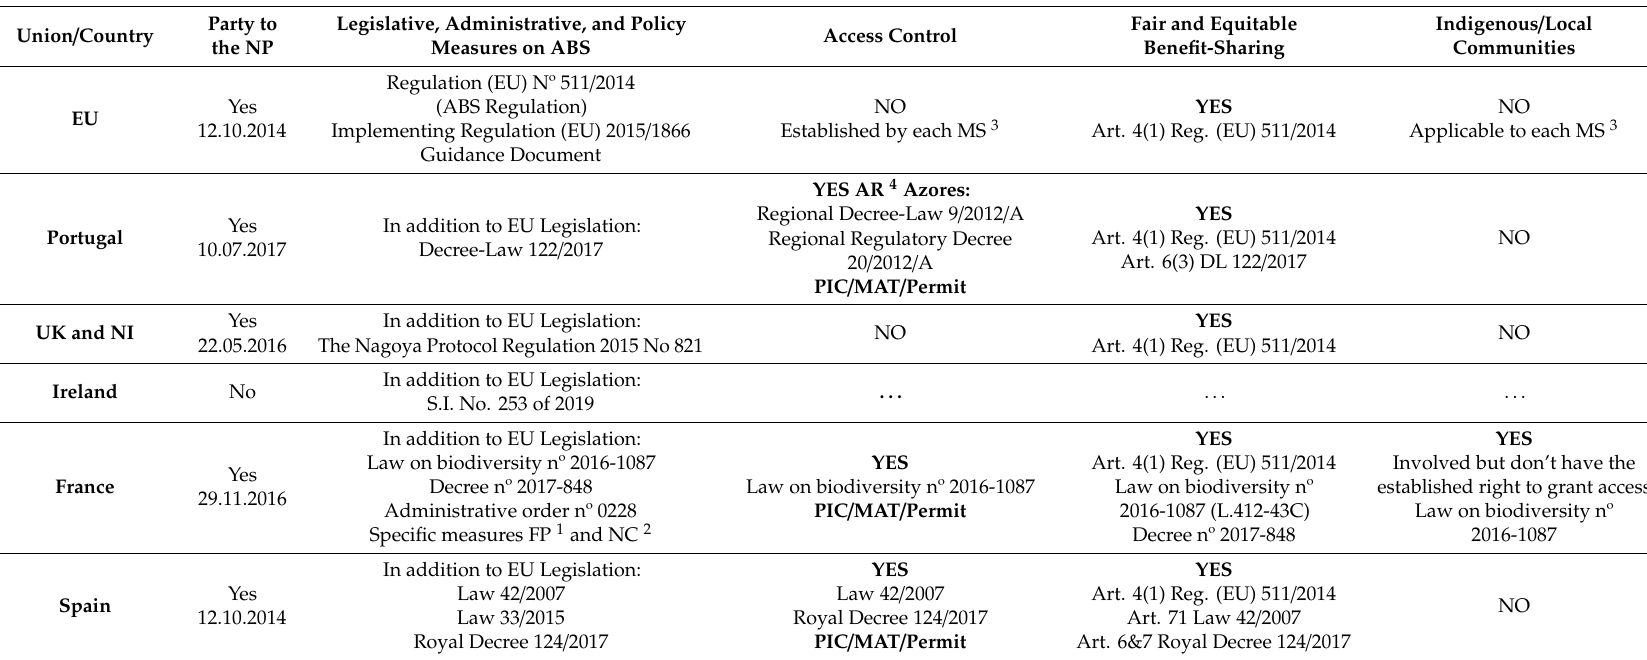
Legend: 1 French Polynesia, 2 New Caledonia, 3 Member State, and 4 Autonomous